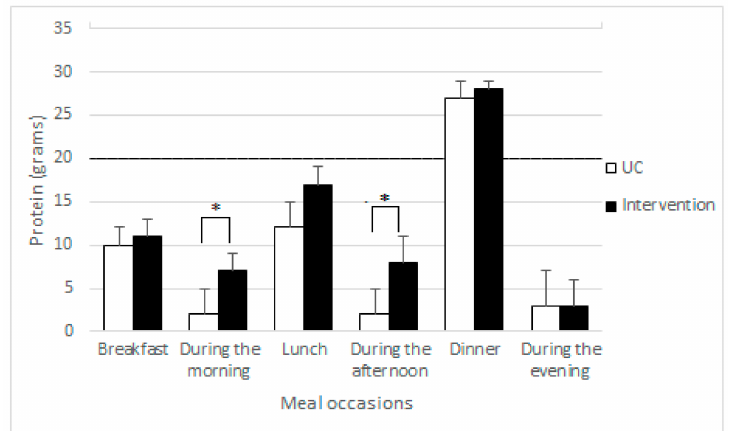
Figure 1. Difference in protein intake (mean ± SD) per meal occasion after the three week interven- tion period of the usual care and intervention group analyzed using independent samples t -tests. * Statistically significant between the groups, p < 0.05. Horizontal line at 20 g represents the minimal threshold that is suggested to be beneficial for muscle protein synthesis. Abbreviations used: UC: Usual Care; SD: Standard